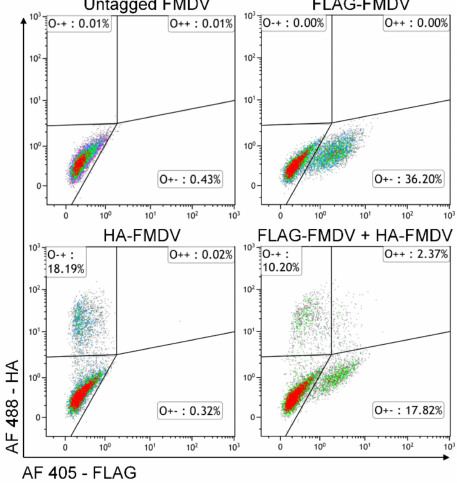
Figure 2. Flow cytometry analysis of goat epithelium cells infected with HA- and FLAG-tagged FMDV O1K/O UKG35. Cells were infected with untagged FMDV O1K/O UKG35 (MOI = 1), FLAG-FMDV O1K/O UKG35 (MOI = 1), HA-FMDV O1K/O UKG35 (MOI = 1), or co-infected with FLAG-FMDV O1K/O UKG35 and HA-FMDV O1K/O UKG35 (MOI = 0.5/virus) for 5 h. Cells were fixed, permeabilised and labelled with anti-HA and anti-FLAG antibodies and analysed by flow cytometry. The percentage of cells positive for HA only (O-+), FLAG only (O+-) and HA plus FLAG (O++) are shown.